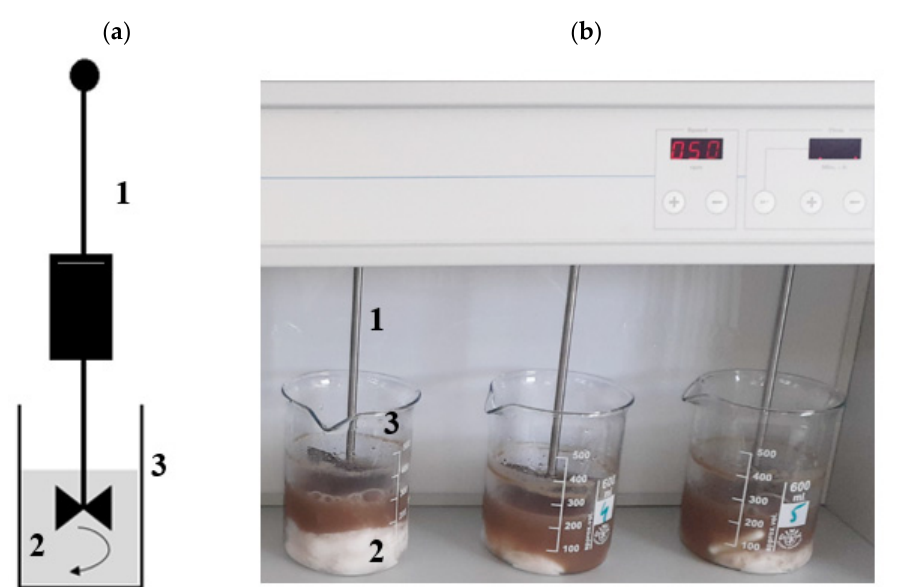
Figure 3. Experimental station in S1: ( a ) scheme; ( b ) photo (1—mechanical stirrer, 2—AGS mixed with SCO 2 , 3—glass reactors).